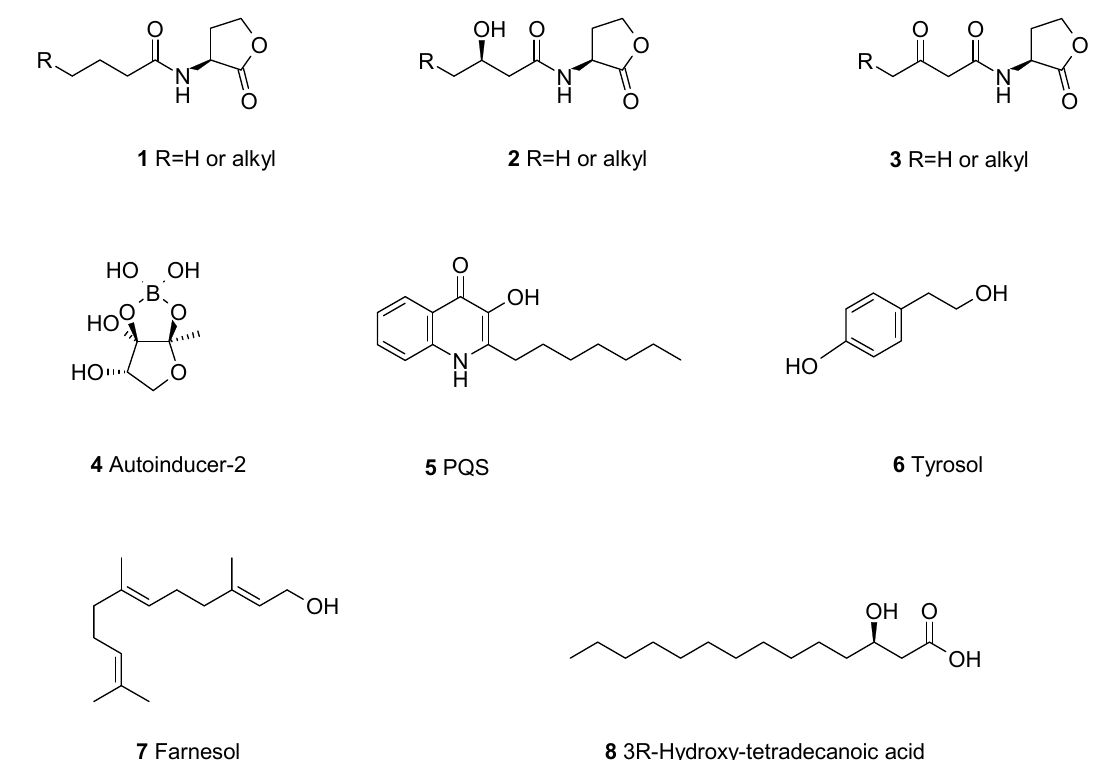
Figure 1. Molecules involved in quorum sensing in bacteria ( 1 – 5 ) and in fungi ( 6 – 8 ).